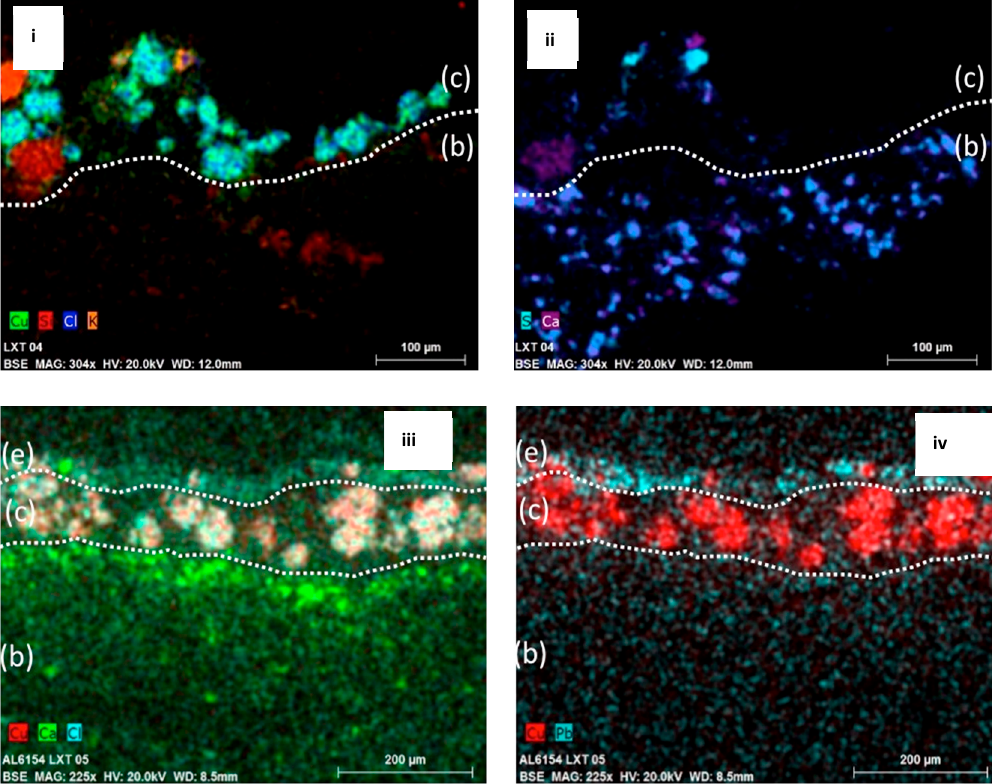
Figure 5. SEM-EDX false color elemental maps of elements for LXT-04 ( i and ii ) and LXT-05 ( iii and iv ) with layers for silk ( b ), green paint ( c ), and white paint ( e ).